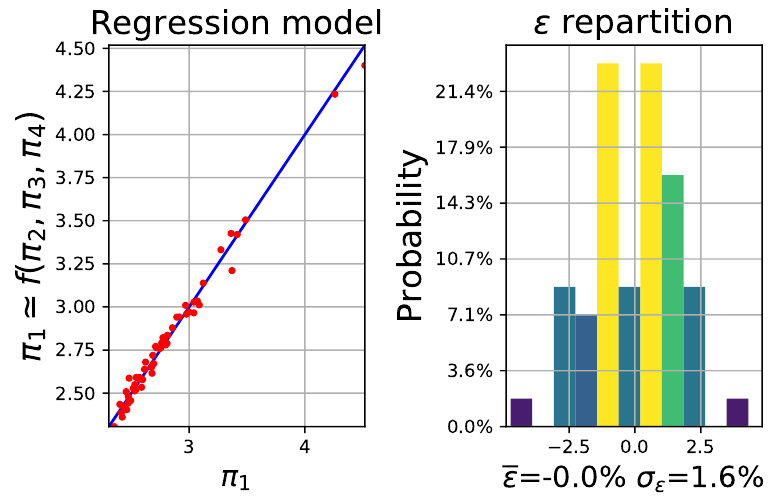
Figure 10. Output of regression model performed on π 1 —validation and error